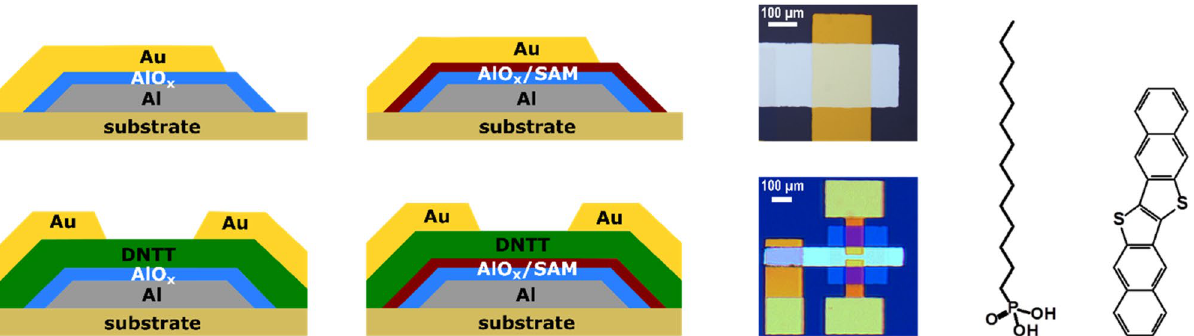
Figure 2. Schematic cross sections and photographs of metal–insulator–metal capacitors and bottom-gate, top- contact TFTs in which the insulator or gate dielectric is either a film of plasma-grown AlO x or a combination of plasma-grown AlO x and an n -tetradecylphosphonic acid SAM. Also shown are the chemical structure of n -tetradecylphosphonic acid and of the organic semiconductor dinaphtho[2,3-b:2 ′ ,3 ′ -f]thieno[3,2-b]thiophene